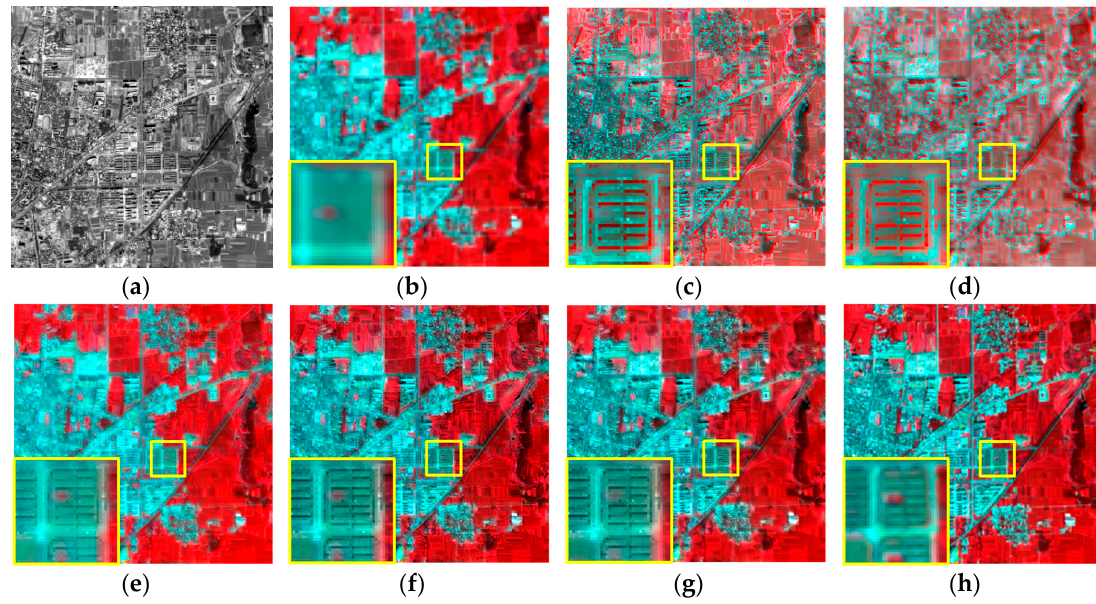
Figure 7. Fusion results of the GF-1 experiment. ( a ) PAN image; ( b ) MS image; ( c ) GS fusion result; ( d ) PCA fusion result; ( e ) AIHS fusion result; ( f ) AWLP fusion result; ( g ) proposed fusion result; ( h ) original MS image.